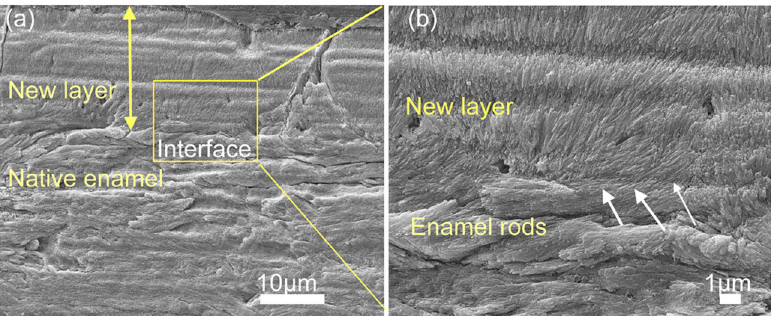
Fig. 5 SEM images of the restored HAP layers treated in P26 after 7 days of incubation in arti fi cial saliva in pH 7.0 at 37 °C. a Cross-sectional view of regenerated HAP layers. b Magni fi ed image of ( a ) (yellow square) depicts the newly formed perpendicularly stacked crystals with a seamless attachment interface with underlying enamel rods. Reproduced with permission from ref.